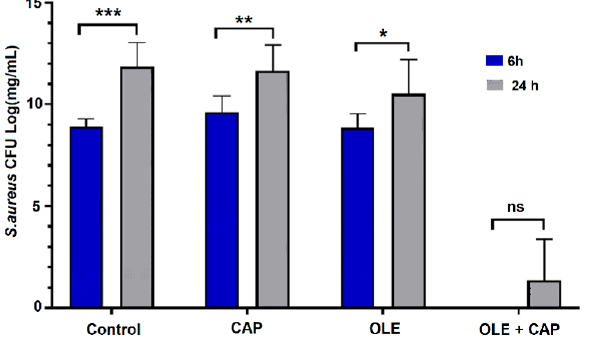
Figure 3. The effects of CAP (1 min exposure time) and/or OLE on S. aureus . The values are reported as mean ± standard error of the mean (SEM) (n = 3), significance at p < 0.05 by One-way ANOVA and Tukey ′ s HSD post hoc test; * p < 0.01, ** p < 0.001, *** p < 0.0001, n.s. not significant.